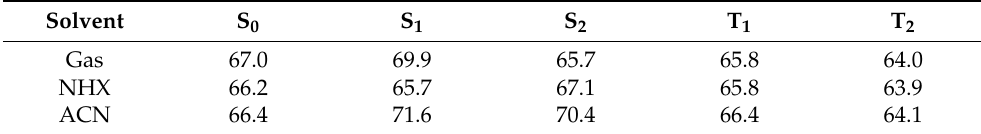
Table 5. The dihedral angle θ of the optimized geometries calculated with the TZ2P basis and the Table 4. The differences in total bonding energies are calculated at the optimized geometries of the CAMY-B3LYP functional with the default parameters for range states with the TZ2P basis and the CAMY-B3LYP functional with the default parameters for range separation, relative to the ground state in the solvent.